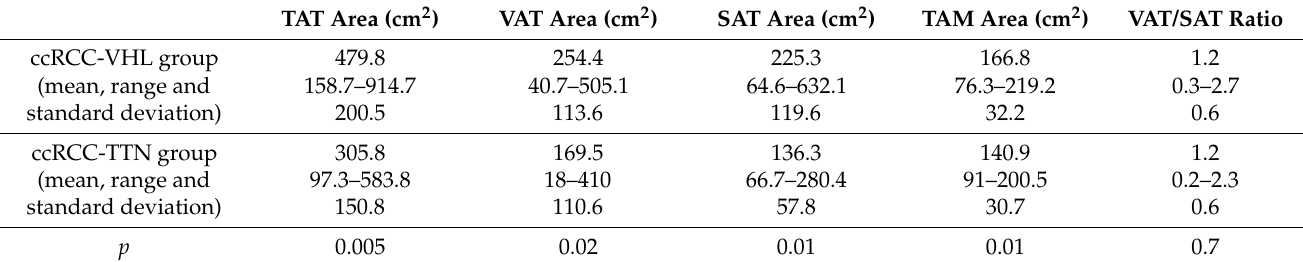
Table 3. Mean of the ccRCC-VHL group and ccRCC-TTN group and Student’s t -test results.